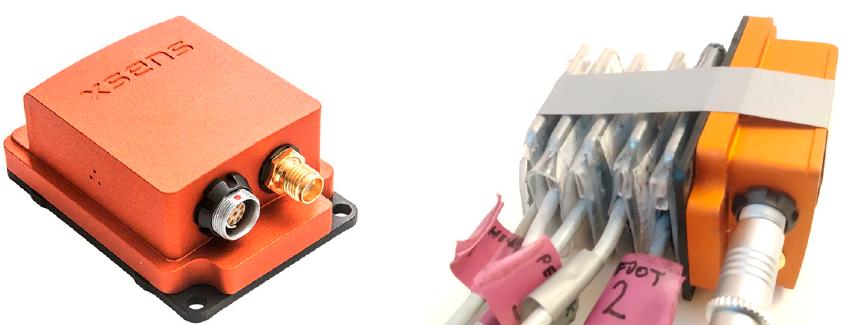
Figure 11. The reference Xsens MTi G-700 sensor ( left ); and the flight controller sensors for synchro- nization measurement ( right ).